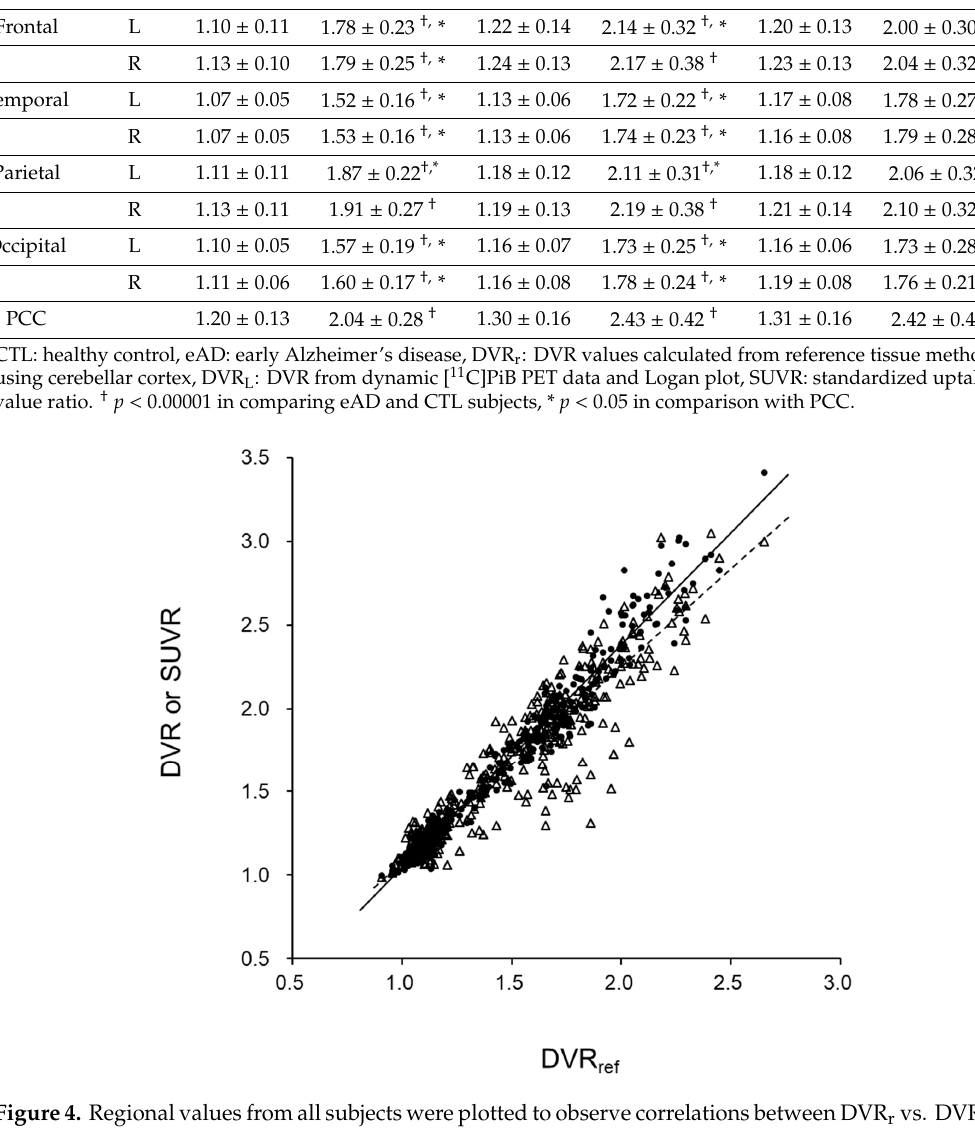
Figure 4. Regional values from all subjects were plotted to observe correlations between DVR r vs. DVR L ( • ) and DVR r vs. SUVR ( ∆ ). DVR r and DVR L showed better correlation (solid line; y = 1.34x − 0.30, r 2 = 0.97) than DVR r and SUVR (dashed line; y = 1.17x − 0.09, r 2 = 0.88).